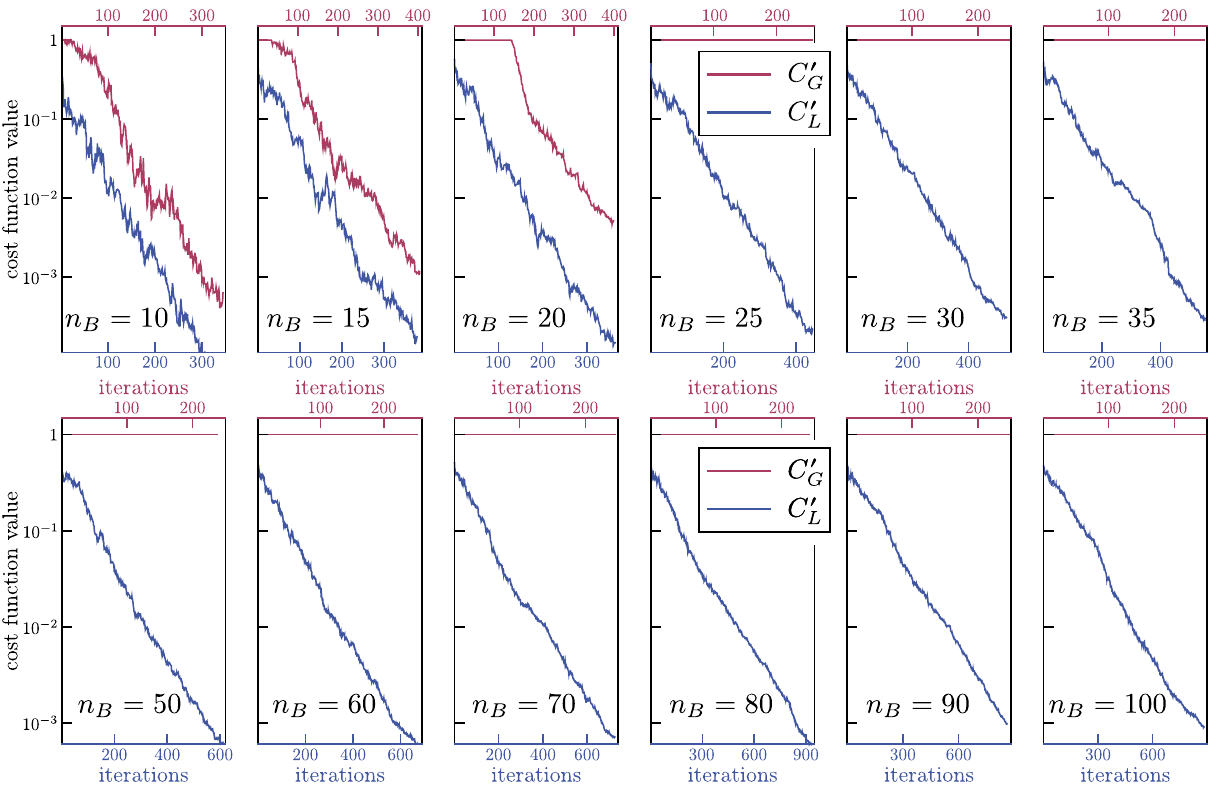
Fig. 5 Cost versus number of iterations for the quantum autoencoder problem de fi ned by Eqs. (25) – (26). In all cases we employed two layers of the ansatz shown in Fig. 4, and we set n A = 1, while increasing n B = 10, 15, … , 100. The top (bottom) axis corresponds to the global cost function C 0 of Eq. (22) G (local cost function C 0 of (23)). As can be seen, C 0 can be trained up to n B = 20 qubits, while C 0 trained in all cases. These results indicate that global cost L L G function presents a barren plateau even for a shallow depth ansatz, and this can be avoided by employing a local cost function.